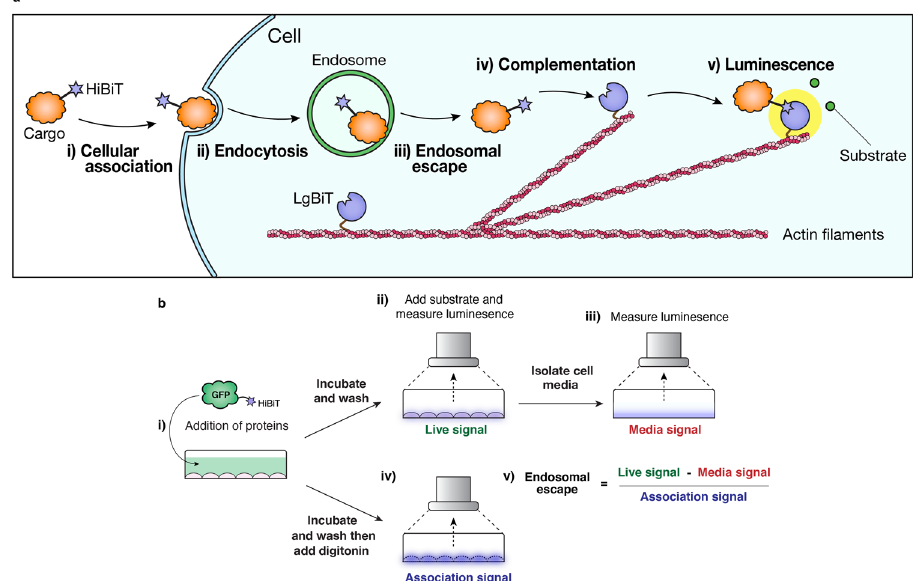
Fig. 1 The Split Luciferase Endosomal Escape Quanti fi cation (SLEEQ) assay enables quanti fi cation of endosomal escape in live cells. a Schematic diagram of how endosomal escape is detected: (i) therapeutic cargo is labelled with HiBiT peptide. (ii) Endocytosis of the HiBiT-tagged cargo results in accumulation in the endosomes. (iii) If endosomal escape occurs, HiBiT-tagged cargo can bind to (iv) LgBiT protein, which is fused to actin fi laments to restrict localisation to the cytosol. (v) Complementation between HiBiT and LgBiT forms a functional luciferase enzyme complex, which gives off bright luminescence in the presence of a substrate. b Schematic diagram showing how the SLEEQ assay is performed. (i) HiBiT-labelled protein is added to the cells. (ii) After incubation for 4 h, excess protein is removed. Addition of fumarizine substrate enables the luminescence from complemented HiBiT/LgBiT in cytosol to be measured. (iii) To take into account any luminescent signal from excreted LgBiT, the cell media is removed and measured separately. (iv) To determine the total association, digitonin is added to the HiBiT-treated cells to permeabilise cell membranes. This enables any HiBiT trapped in endosomes or stuck to the plasma membrane to complement with LgBiT. (v) Formula for calculating endosomal escape ef fi